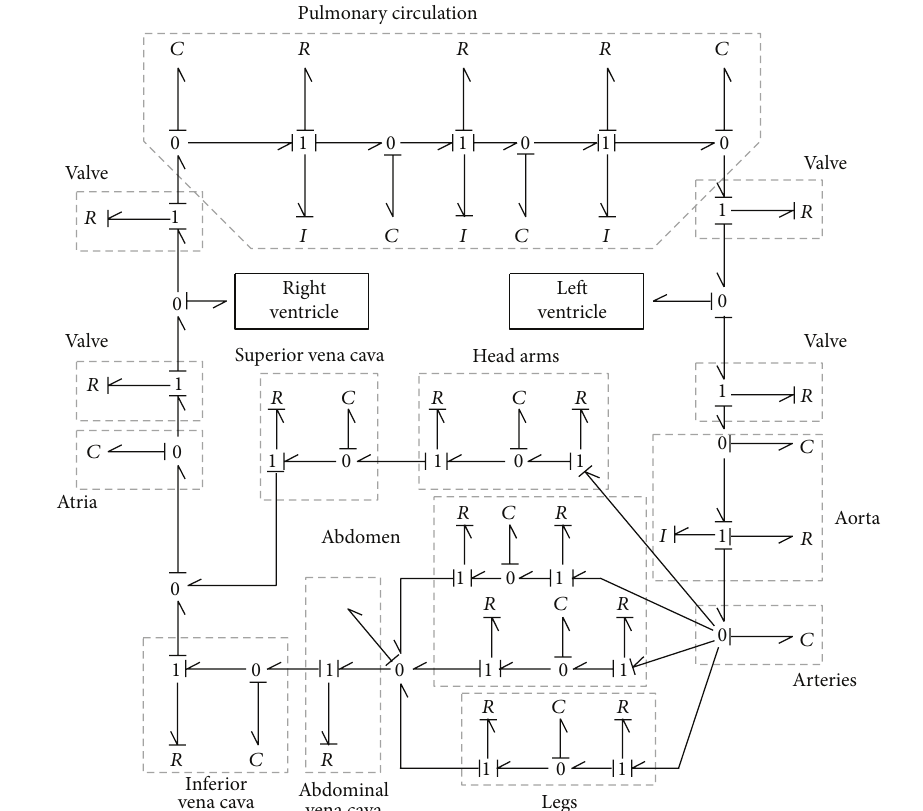
Figure 13: Bond Graph model of the